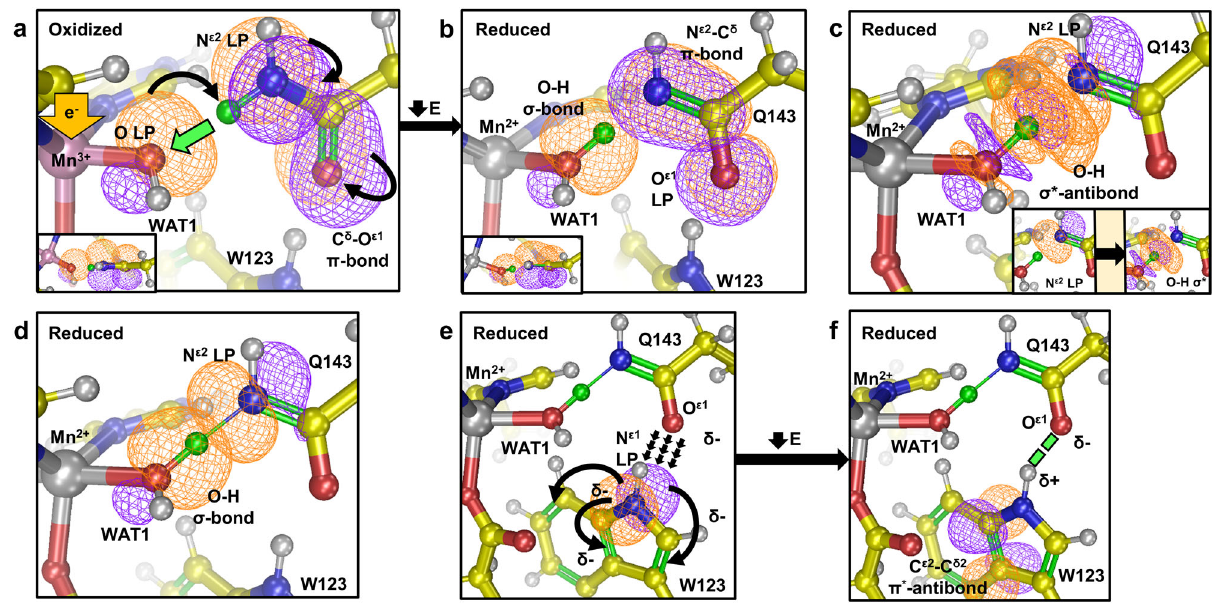
Fig. 3 The suggested mechanism of Gln143 → WAT1 proton transfer utilizing bonding orbitals and optimal resonance forms calculated from chemist ’ s localized property-optimized orbital (CLPO) analysis of the neutron structures. Orange and purple contours indicate the positive and negative orbital wave functions, respectively. Curved arrows represent electron pushing. a , b The reduction of Mn 3 + to Mn 2 + instigates a strong covalent need for the exposed lone pair (denoted LP) of – OH(WAT1). This is chemically remediated by the acquisition of a proton (green atom) from the proximal Gln143 amide. The dominant resonance structure of the amide anion is with a N ε 2 – C ε 1 double bond as a result of N ε 2 LP delocalization from a . c Despite proton donation to WAT1, Gln143 still demonstrates covalent character with the proton (green atom). The new N ε 2 LP participates in electron density transfer to the σ * - antibonding orbital of O – H(WAT1). Donor acceptor orbital analysis calculates a stabilizing energy of 1.4 kcal mol − 1 for this hyperconjugated interaction. The inset in the lower-right corner illustrates individual orbital representations. d Due to the hyperconjugation illustrated in c , the hydrogen bond between N ε 2 (Gln143) and O – H(WAT1) has partial σ -bonding character contributing to and increasing the strength of the hydrogen bond characteristic of short- strong hydrogen bonds (SSHBs). CLPO calculations suggest the proton is covalently shared between WAT1 and Gln143, with percentages of 64 and 36%, respectively. e , f The increased electronegative character of O ε 1 electrostatically polarizes Trp123. This is achieved through the stabilizing delocalization of the N ε 1 (Trp123) LP into the conjugated ring. The major stabilizing interaction decreases energy by 13.52 kcal mol − 1 and is the donation of electron density from the N ε 1 (Trp123) LP into the adjacent C ε 2 – C δ 2 π * -antibonding orbital. The polarization of Trp123 allows an SSHB between Gln143 and Trp denoted by the green dashes. The hyperconjugation and polarization of Trp123 are thought to contribute to the stability of the amide